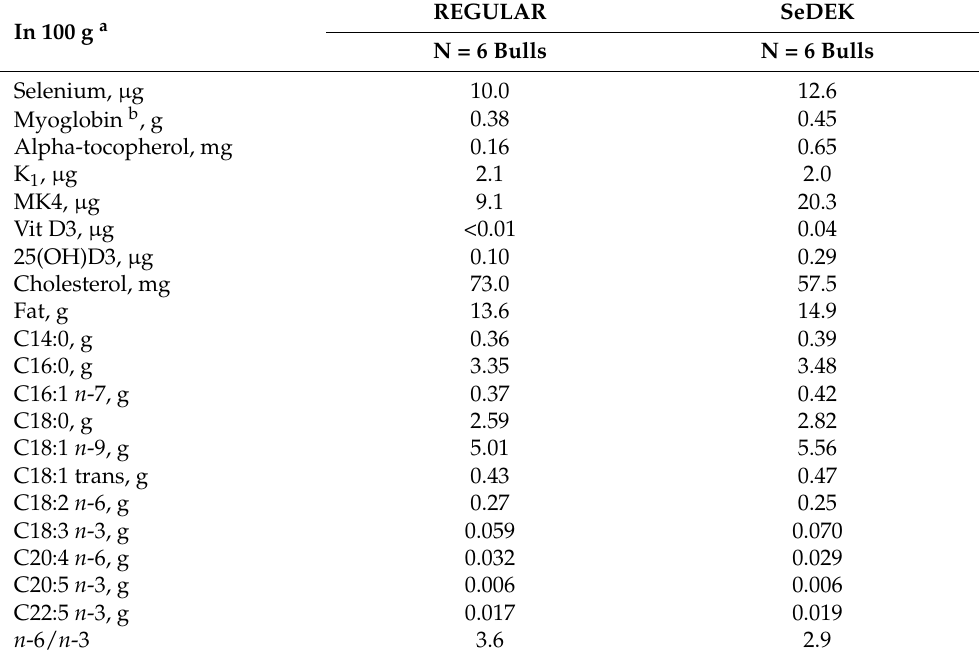
Table 1. Measured nutrient contents in minced beef meat; control bulls (REGULAR) and bulls fed nutrient optimized composite feed (SeDEK) [39]. Reproduced with permission from Kaveri Thakuria, Meat Science, Elsevier, 2022. REGULAR SeDEK In 100 g a N = 6 Bulls N = 6 Bulls